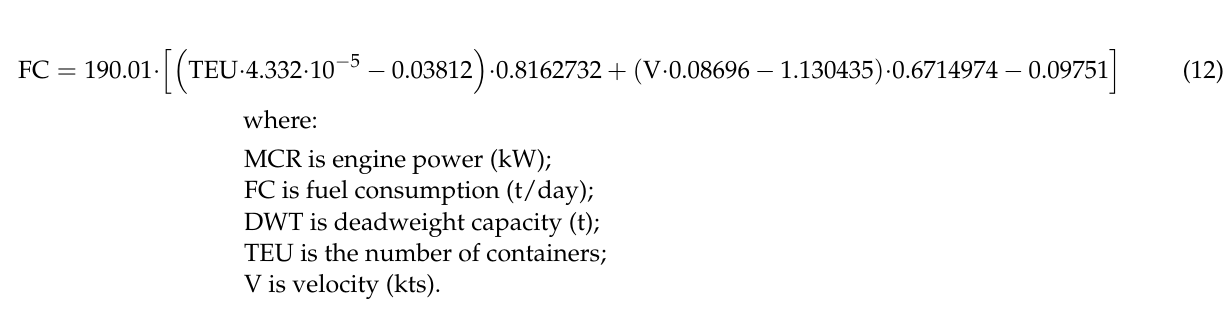
Table 4. An overview of the neural networks that were developed to estimate the engine power and fuel consumption of bulk carriers, where: BP—error back propagation algorithm, CG—conjugate gradient algorithm, PI—pseudo-inverse algorithm and RMSE—root mean square error.